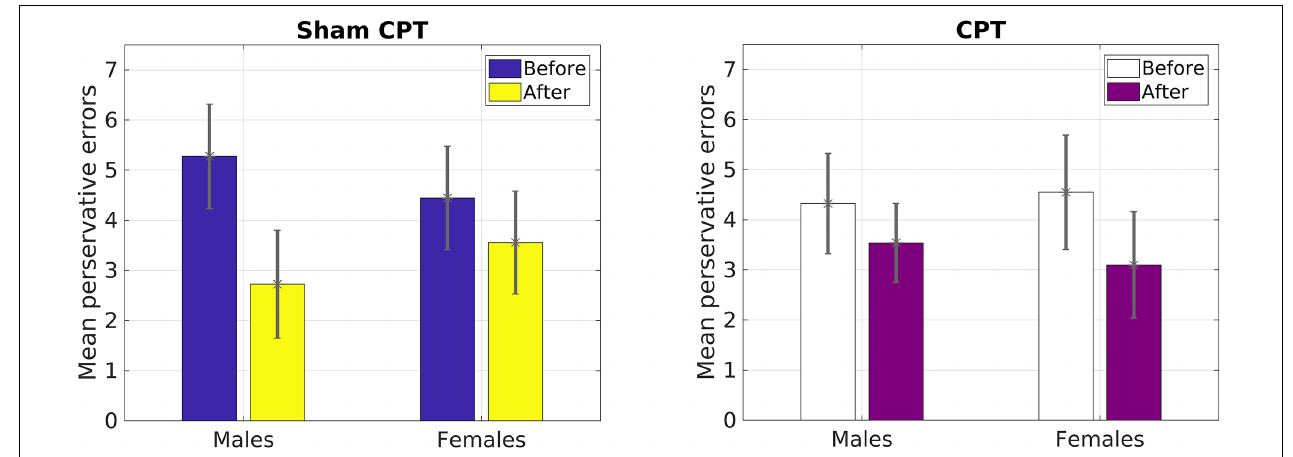
FIGURE 3 | Mean number of perseverative errors as a function of sex and condition in Study 1.